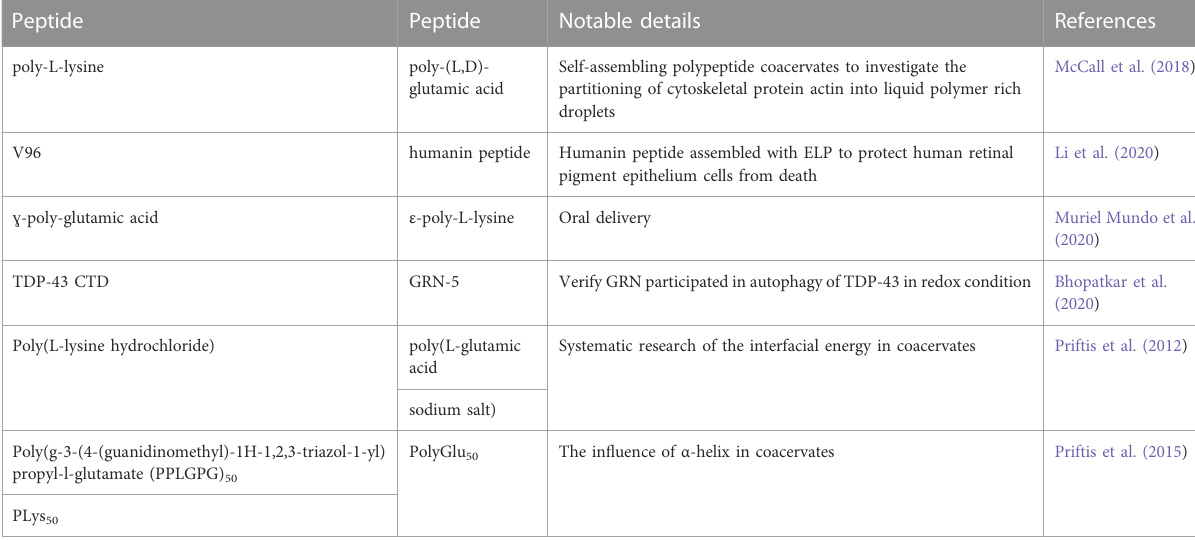
TABLE 2 Summary of peptide-peptide coacervates. Peptide